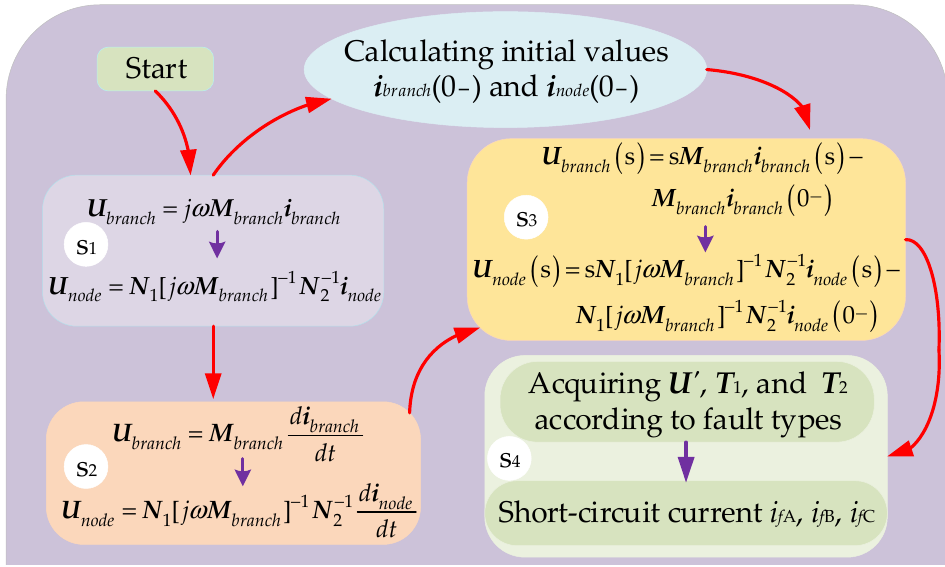
Figure 9. The conversion processes of short-circuit model.